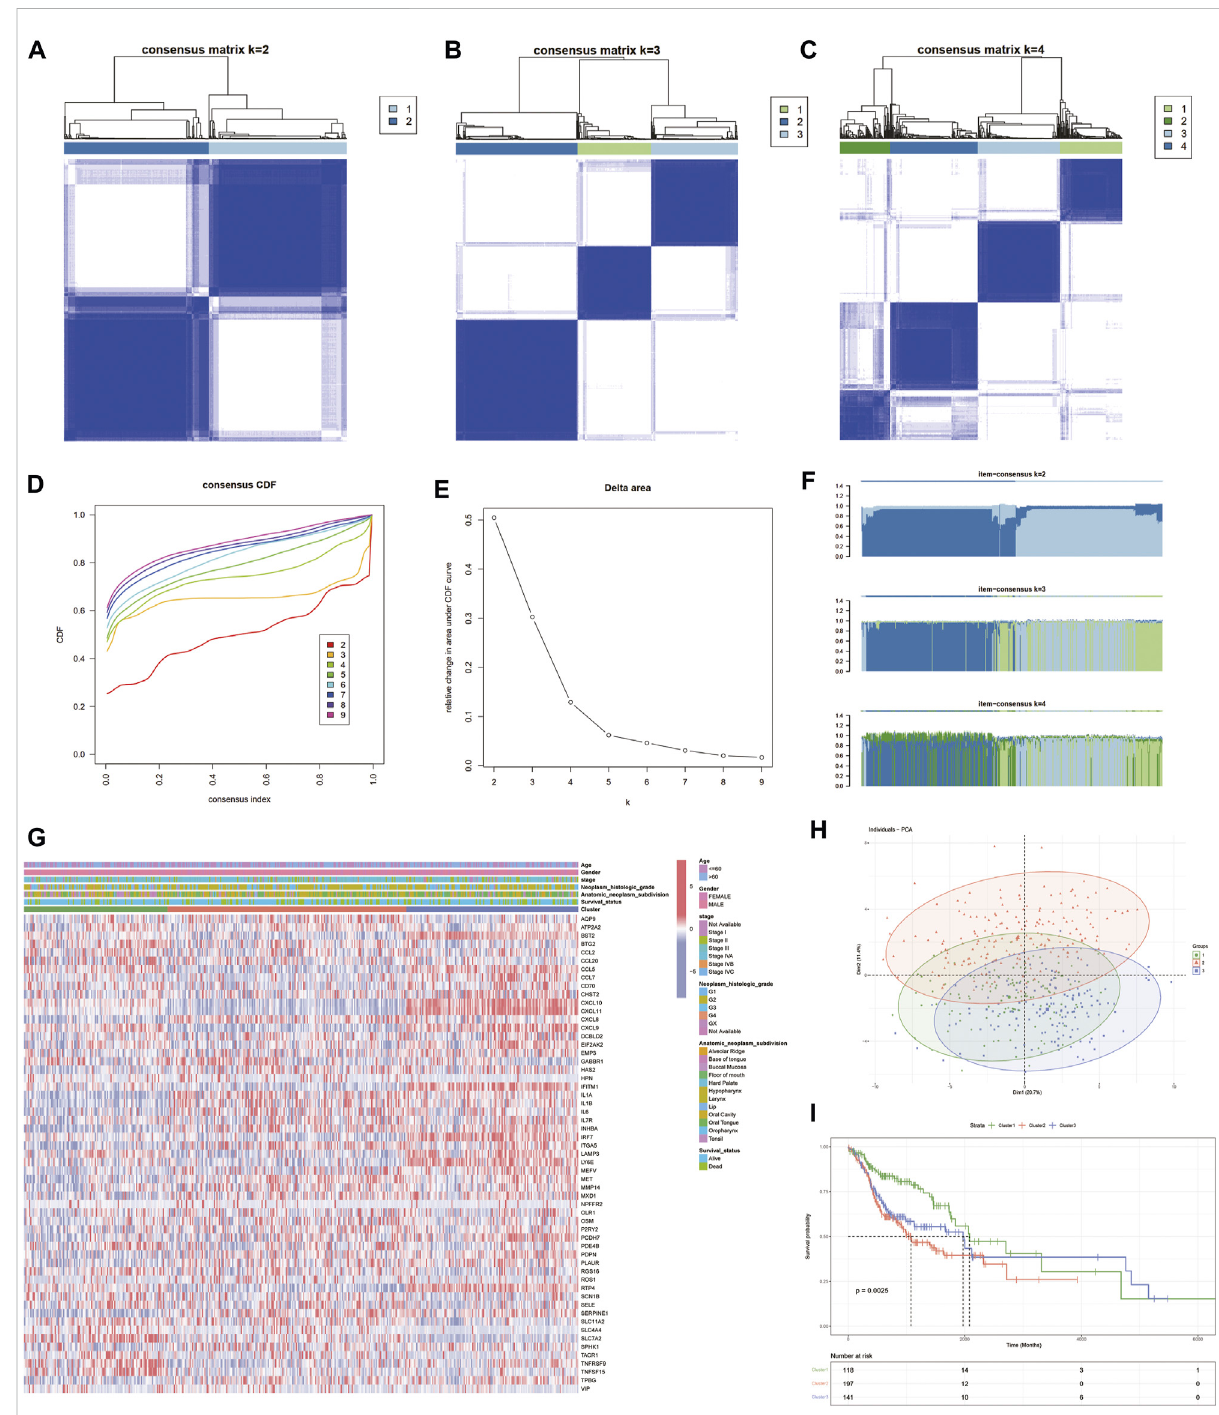
FIGURE 3 Identi fi cationofin fl ammatoryfactorgene-associatedHNSCC subtypesintheTCGAcohort. (A – C) Heatmapdepictingtheconsensusmatrixat k =2,3,and4intheTCGAcohort. (D – F) Cumulativedistributionfunction(CDF),deltaareaplotandtraclingplotintheconsensusclusteranalysis. (G) Showstheassociationofgeneexpressionlevelsandclinicopathologicalfeaturesbetweensubclasses. (H) PCAplotsshowinggooddifferentiation. (I) Prognostic KM curve plot showing signi fi cant differences in prognosis among the